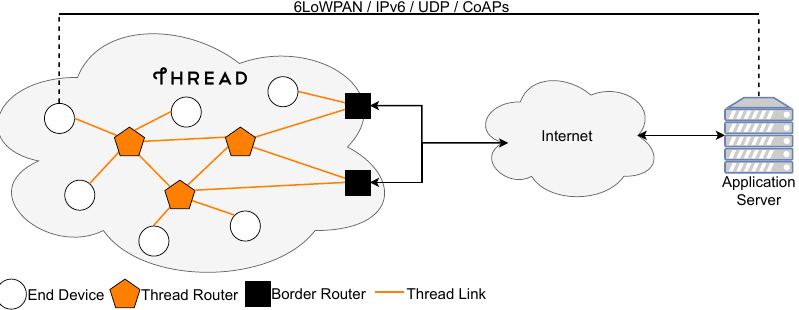
Figure 1. Typical Thread network with access to an application server over the